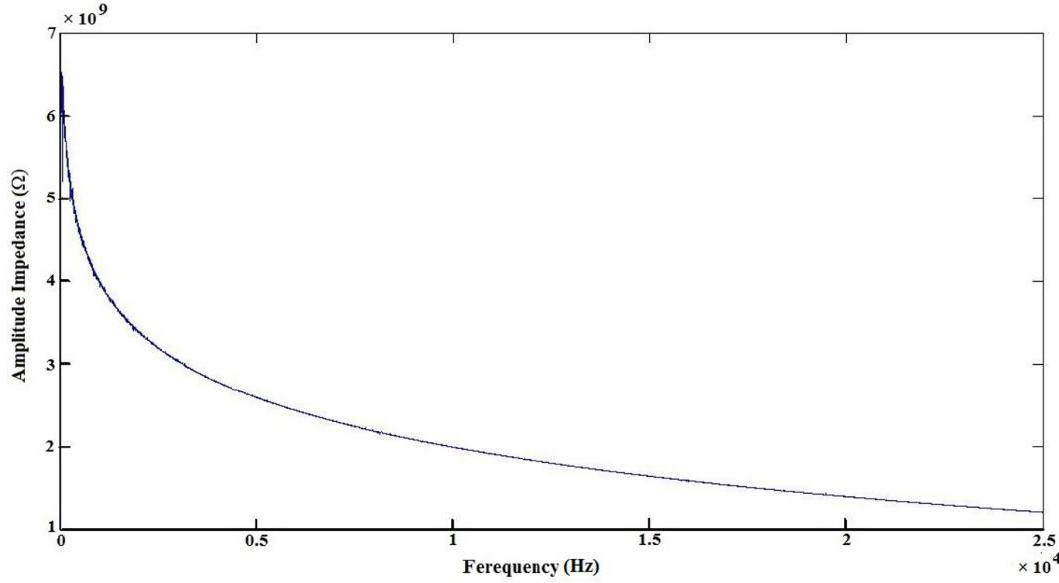
Figure 4. The experimental amplitude impedance of electrospun PVDF nanofibers mats as a function of frequency at room temperature.